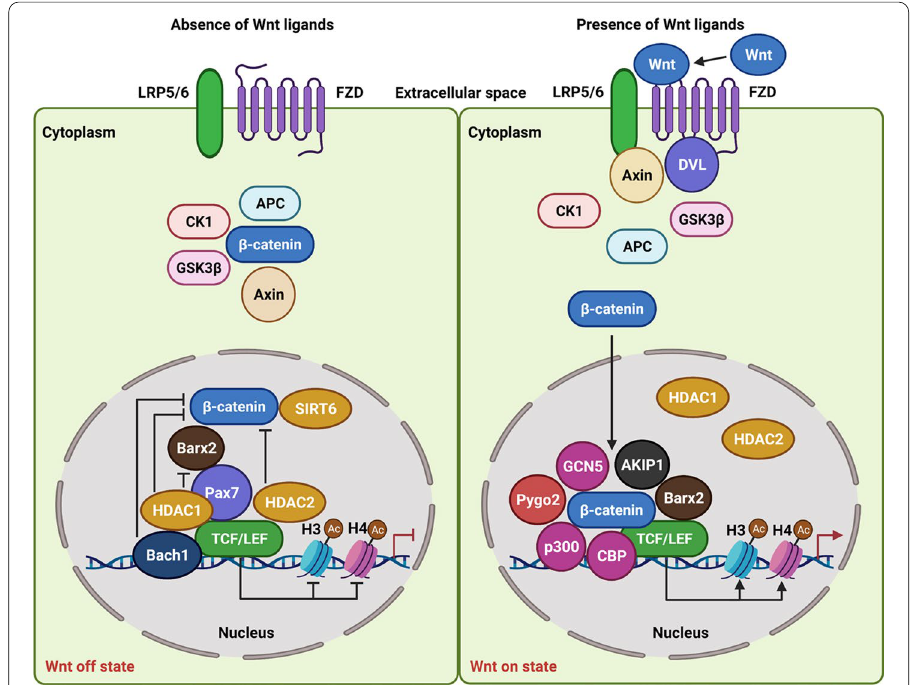
Fig. 2 Molecular mechanisms associated with histone acetylation in β-catenin-TCF/LEF-dependent transcription of Wnt target genes. In the Wnt off state, TCF/LEF interacts with HADC1 and HADC2 to inhibit gene transcription by inhibiting acetylation of histone H3/H4. SIRT6 binds to β-catenin and participates in inhibition of β-catenin-TCF/LEF-dependent transcription. Bach1 binds to HDAC1 to suppress β-catenin. Pax7 inhibits the function of Barx2 in activating β-catenin, to block histone acetylation-associated gene transcription. In the Wnt on state, β-catenin interacts with TCF/LEF to release HDAC1 and HDAC2 to transcription factor binding sites. Additionally, β-catenin recruits p300, CBP, AKIP1, and Barx2 to facilitate histone acetylation at the target gene promoter. Pygo2 is also recruited by β-catenin to bind to p300 and GCN5 to promote histone acetylation to induce gene